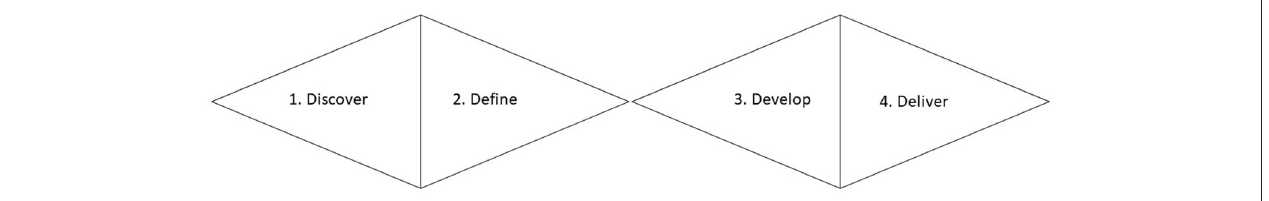
FIGURE 1 | Double diamond design